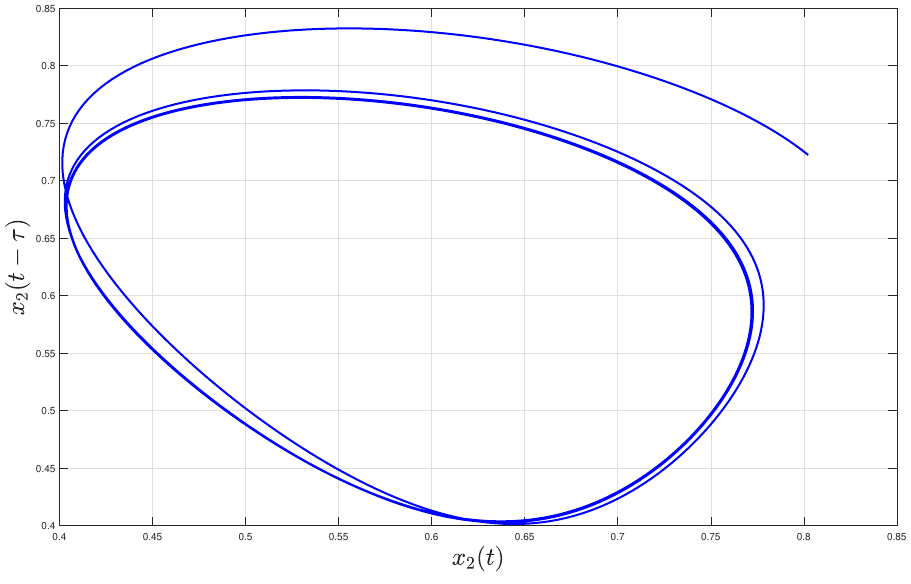
Figure 6. Phase diagram of x 2 ( t ) with 0.6 = τ > τ ∗ = 0.5303, the system with a Hopf